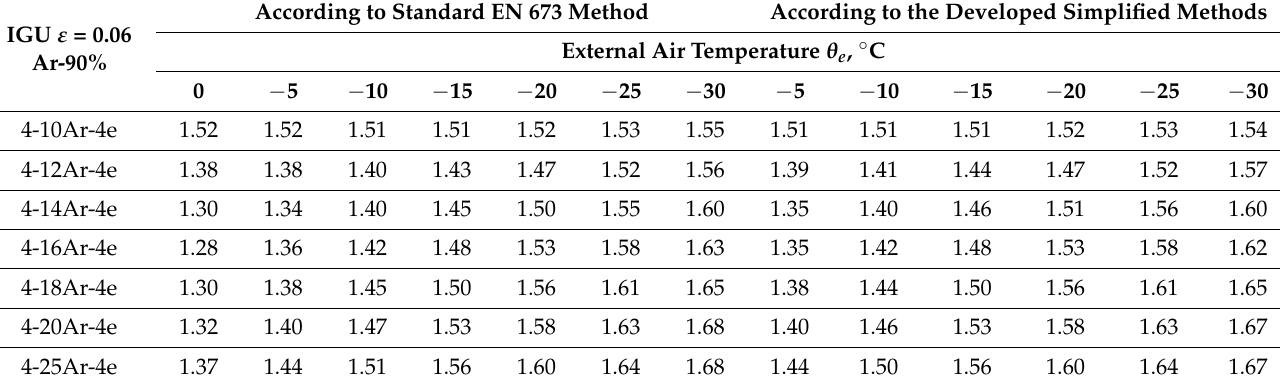
In order to verify the reliability of the composed simplified methods, the differences of U g - values were found between the values calculated in accordance with the standard methodology and the values calculated according to the developed simplified recalculation formulas. Calculation data using the standard methodology and simplified formulas for double- glazed IGU with 16 mm cavity, filled with argon gas and one Low-E coating (4-16Ar-4e), are given in Table 8, and for triple-glazed glass unit with 16mm cavities, filled with argon gas and two Low-E coatings (4e-16Ar-4-16Ar-4e)—in Table